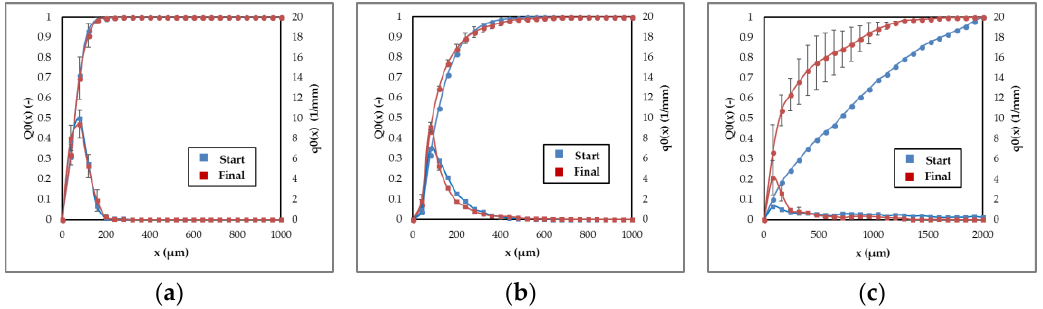
Figure 6. Breakage experiments of different particle fractions: ( a ) small particles, ( b ) seed particles, ( c ) large particles.